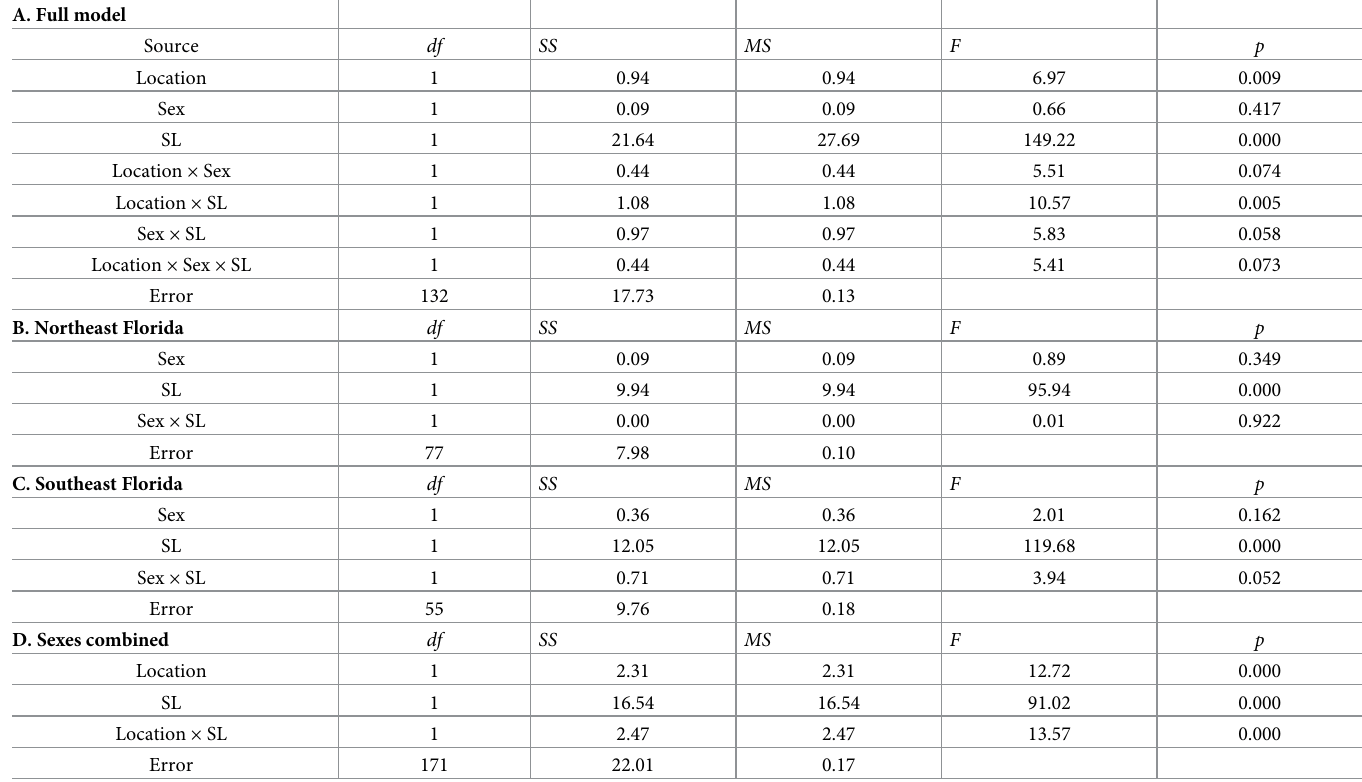
Table 2. Analyses of covariance (ANCOVA) tables for ln total mercury ( μ g g -1 ) concentrations in lionfish muscle tissue. A. Full